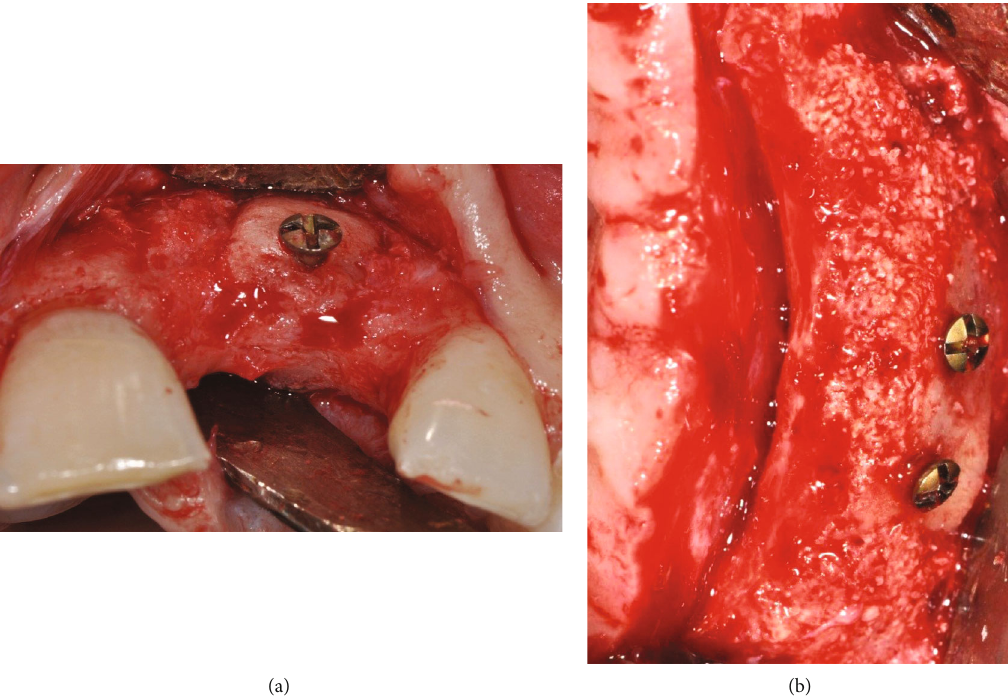
Figure 6: View of the grafted sites 6 months postoperatively: (a) case no. 1; (b) case no. 2.